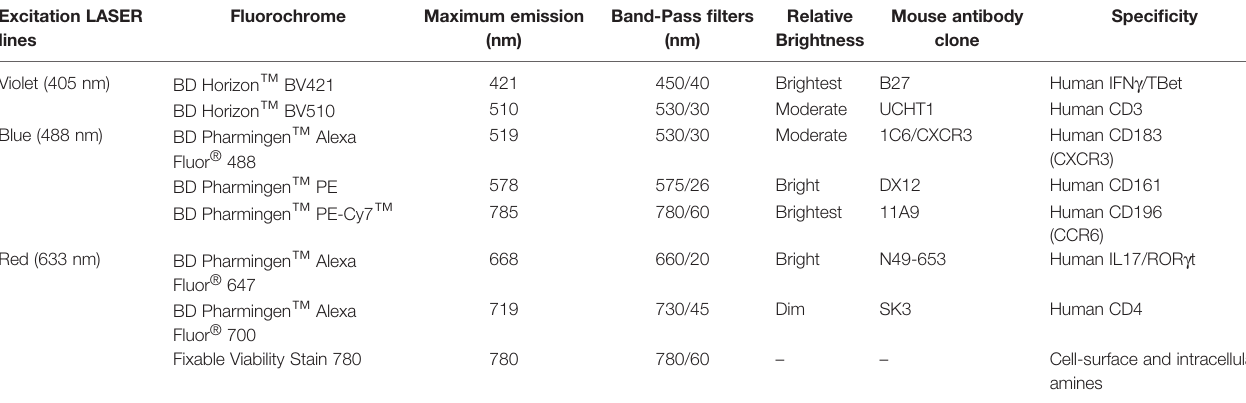
TABLE 1 | Parameter speci fi cations and BD FACSAria III cytometer con fi guration used for data acquisition. Excitation LASER lines